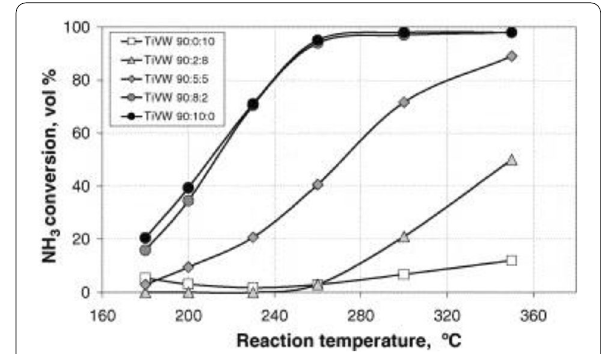
Fig. 15 N 2 selectivity to a N 2 and b N 2 O during NH 3 oxidation as a function of reaction temperature [153]